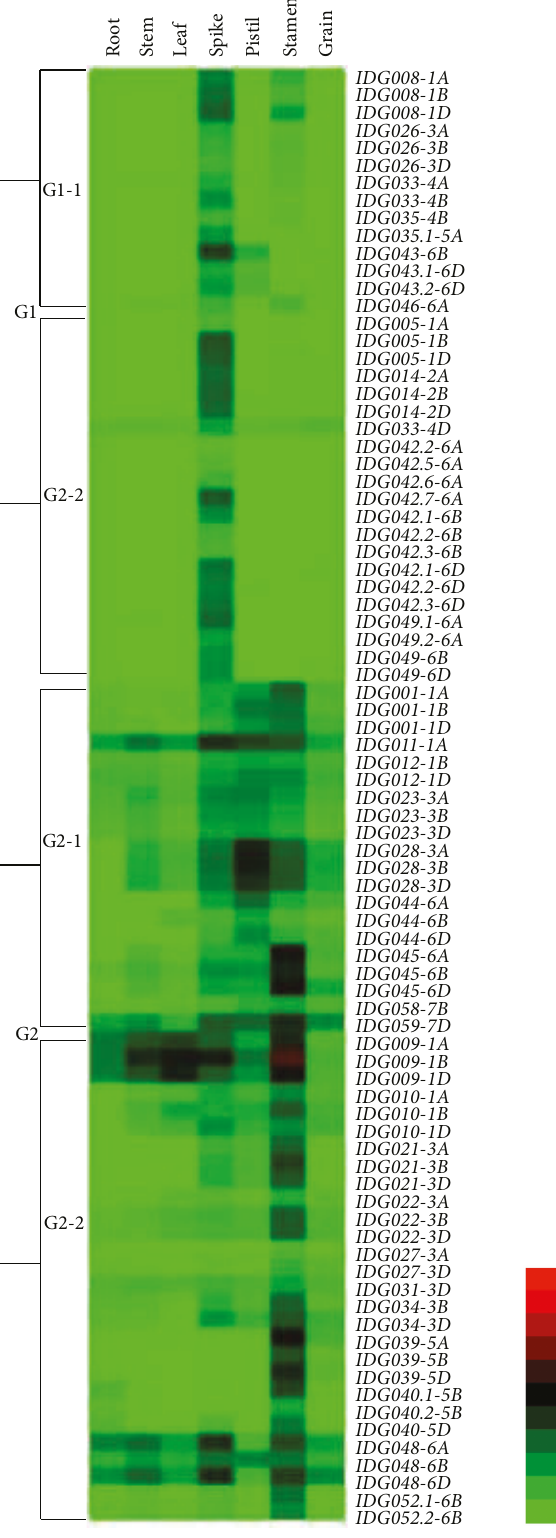
Figure 1: Relative expression abundance of the identi fi ed genes in di ff erent tissues based on RNA-seq data. Apart from seven genes with a negligible number of reads, the remaining 163 genes were divided according to their expression pro fi les into three groups, each of which had two